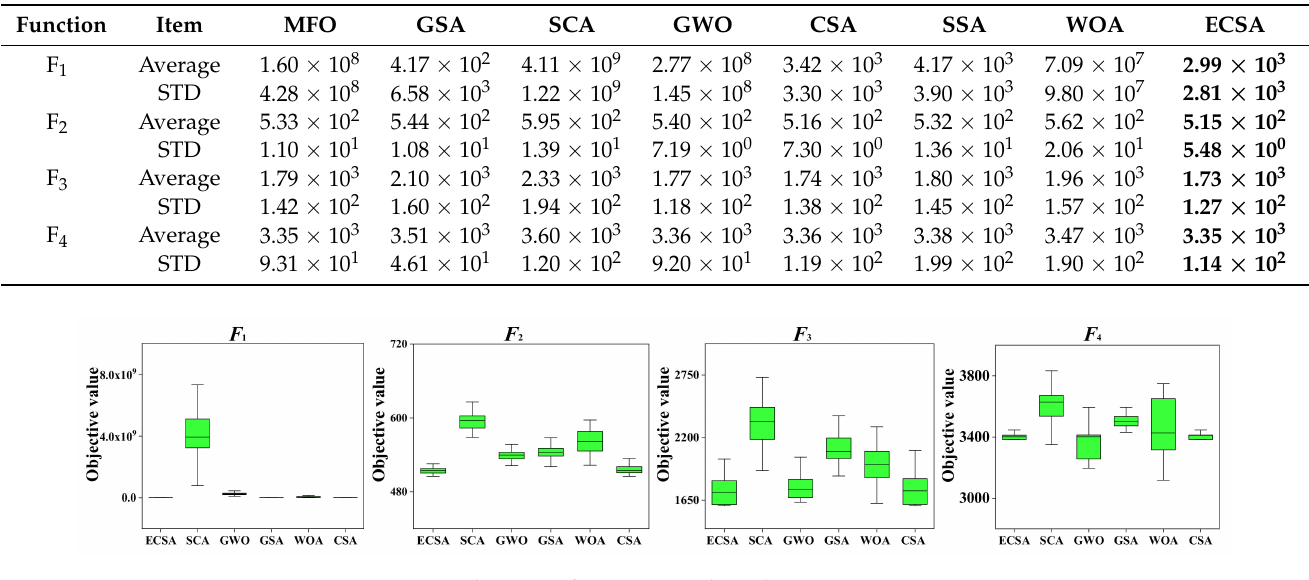
Figure 1. Box diagram of test statistical results.